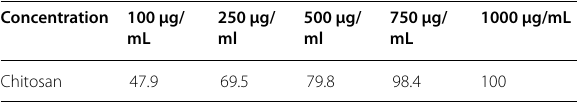
Table 2 Ch-NPs antioxidant